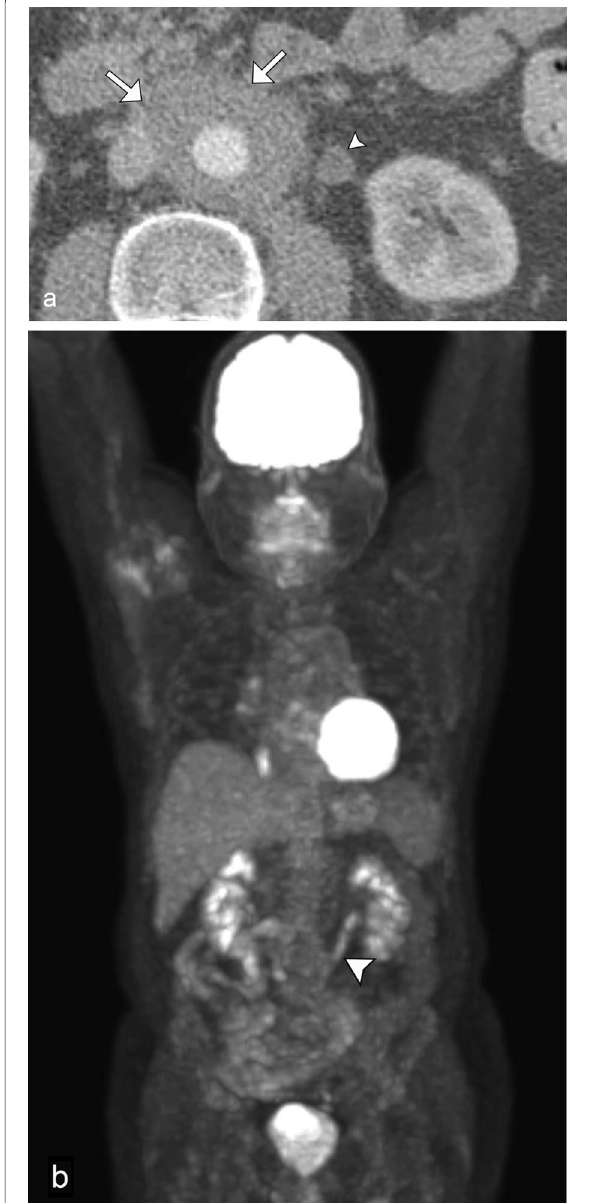
Fig. 13 Retroperitoneal fibrosis. Axial contrast CT ( a ) of the abdomen demonstrates retroperitoneal mass-like soft thickening enveloping the aorta without lifting it anteriorly (arrows), and a dilated left ureter (arrowhead). This mimics retroperitoneal lymphomatous disease, although lymphoma tends to lift/displace the aorta/IVC. F18-FGD PET/CT MIP ( b ) demonstrates a medialized left ureter (arrow). Note the lack of FDG avidity in the expected region of the retroperitoneal mass. Findings are consistent with retroperitoneal